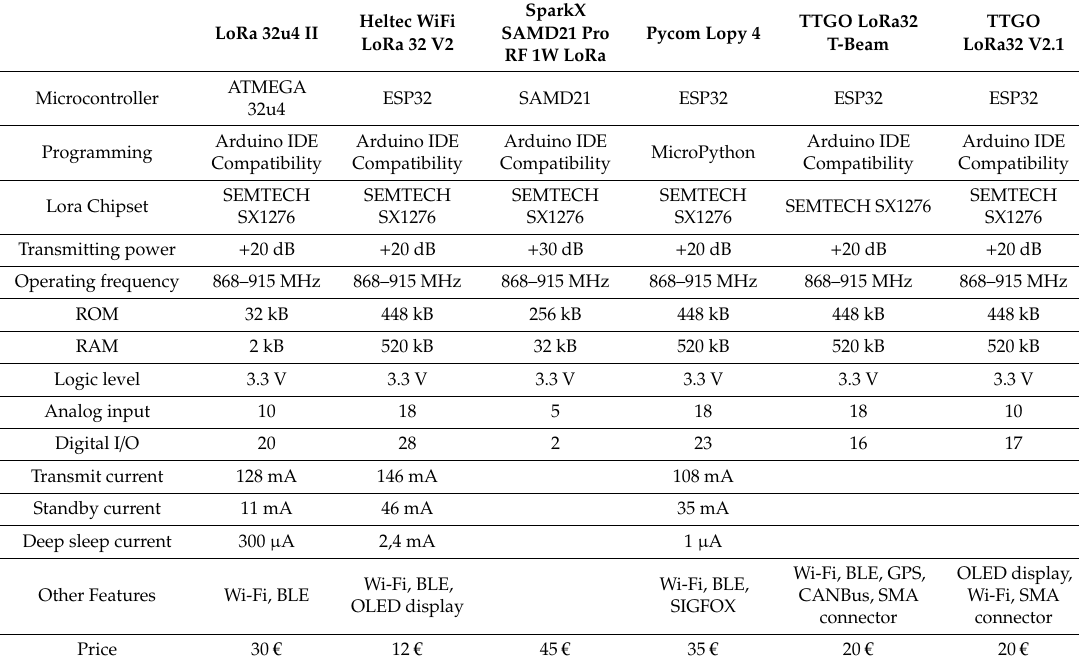
Table 2. Technical characteristics of LoRa integrated